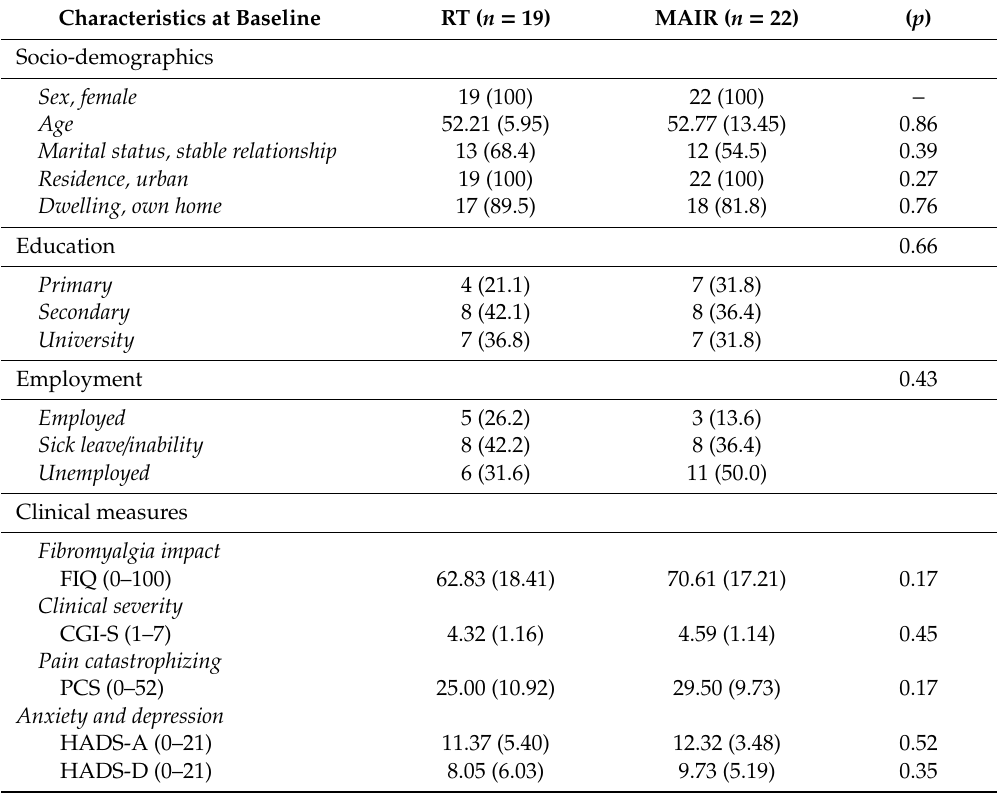
Table 2. Baseline socio-demographic and clinical characteristics of study